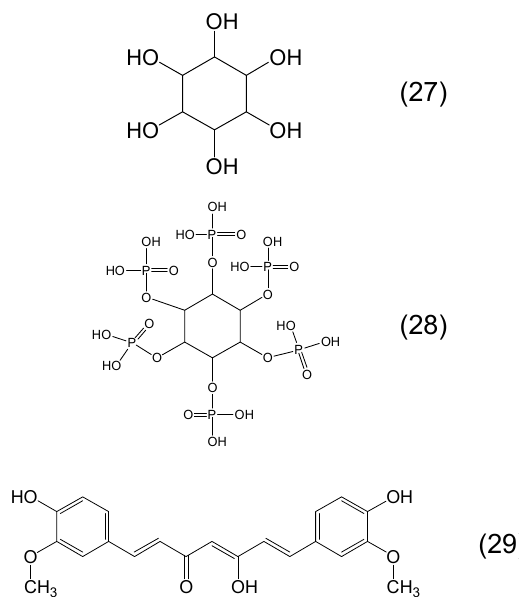
Figure 8. Examples of phytochelators containing hydroxyl and phosphate as the metal binding site. Inositol or cyclohexane-1,2,3,4,5,6-hexol ( 27 ), inositol hexaphosphate (phytic acid) or (2,3,4,5,6-pentaphosphonooxycyclohexyl) dihydrogen phosphate ( 28 ) curcumin or (1 E ,6 E )-1,7-bis(4-hydroxy-3-methoxyphenyl)hepta-1,6-diene-3,5-dione ( 29 ).